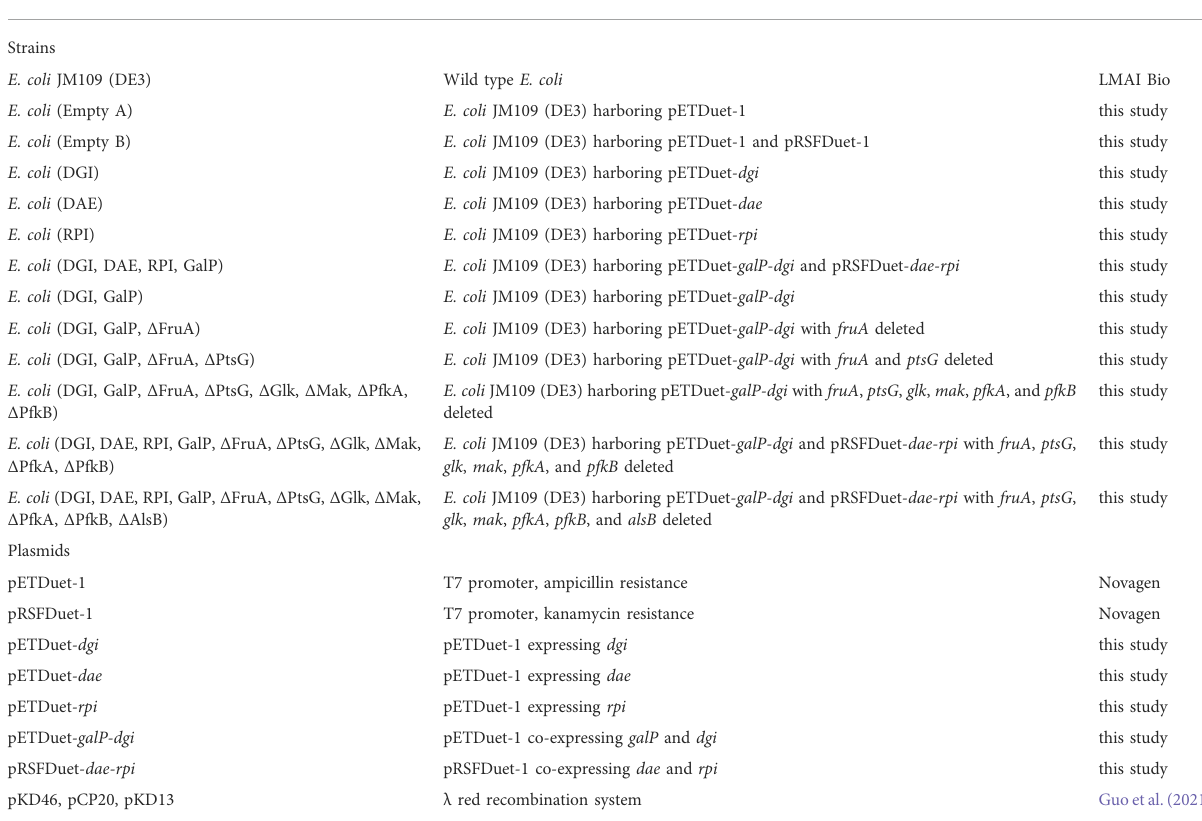
TABLE 1 Strains and plasmids used in this